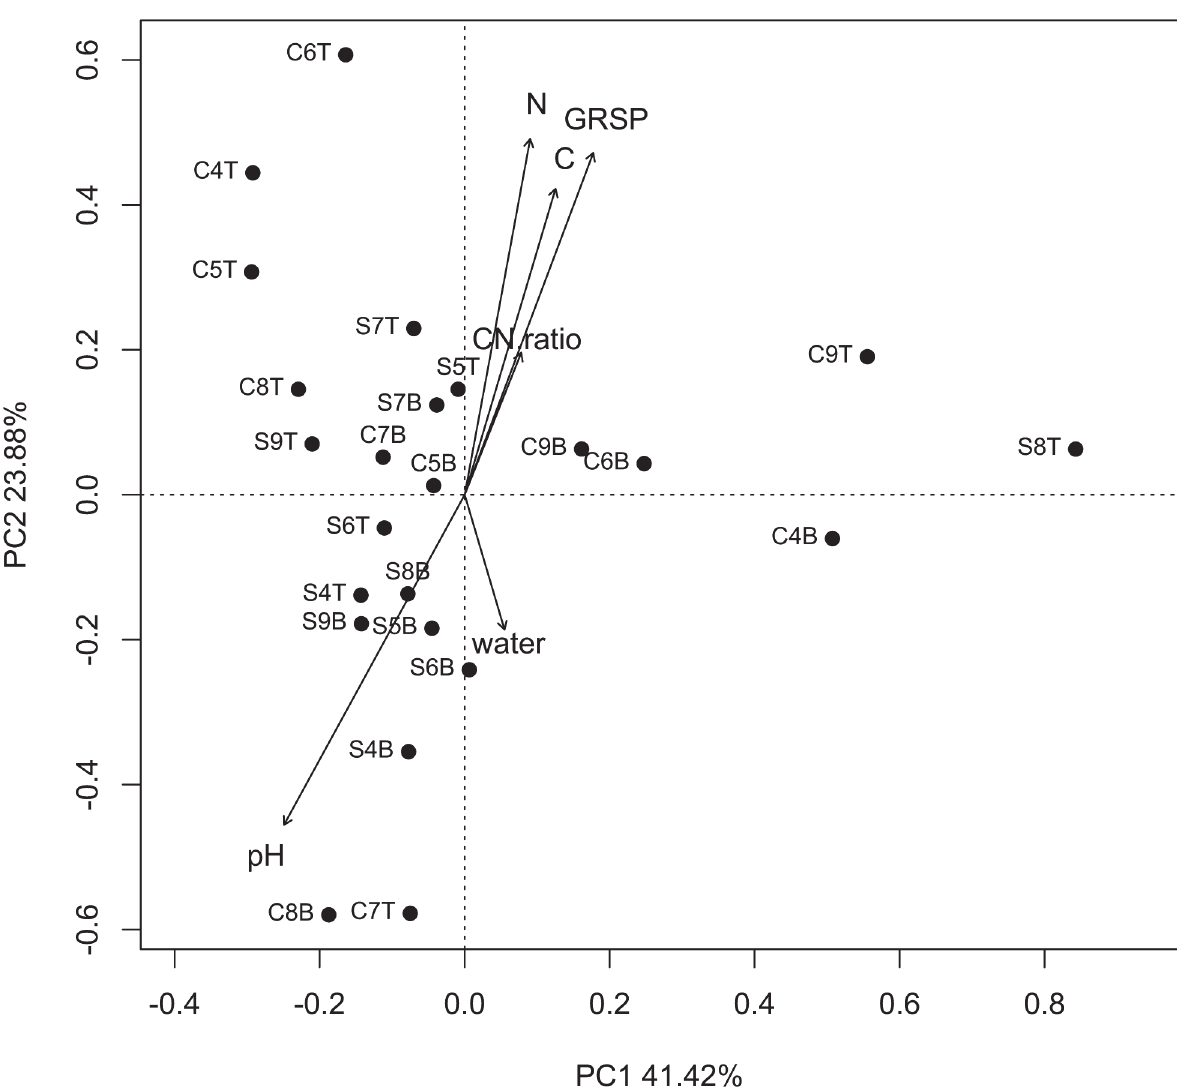
Figure 3. Multidimensional scaling plot (Bray-Curtis dissimilarity metric) displaying the relatedness of sequence library composition based on order-level classification. Soil intervals and sequence libraries from them are designated as CT (cheatgrass 0 – 4 cm), CB (cheatgrass 4 – 8 cm), ST (sagebrush 0 – 4 cm) and SB (sagebrush 4 – 8 cm). Each sequence library is accompanied with a sample number (4, 5, 6, 7, 8 or 9). Arrows represent projections of soil variables (water content (water), glomalin related soil protein (GRSP), % carbon (C), % nitrogen (N), C:N ratio and pH) relative to community